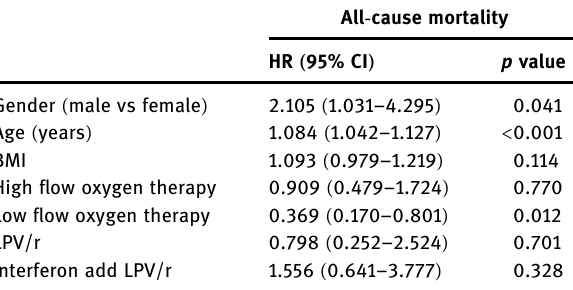
Table 2: Cox proportional hazard regression con fi rmed that the low - fl ow oxygen therapy was independent protective factor for in - hos - pital death after adjusting for age, gender, and